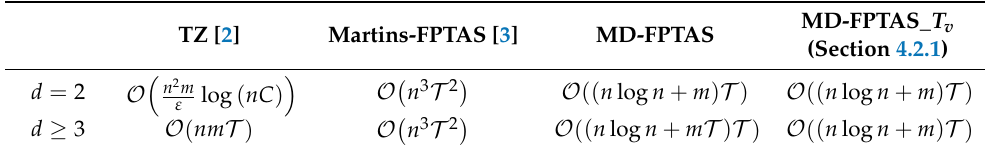
Table 2. Complexities of the different state of the art FPTAS for MOSP problems. Recall that c max j C : = max j ∈{ 2,..., d } , and T denotes the size of the tensors T v , i.e., the max. number of paths to c min j